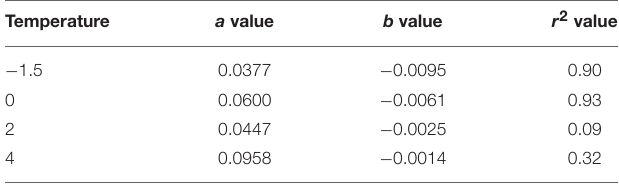
TABLE 5 | Model variables for maximal quantum yield based on irradiance at discrete temperatures. Temperature a value b value r 2 value − 1.5 0.0377 − 0.0095 0.90 0 0.0600 − 0.0061 0.93 2 0.0447 − 0.0025 0.09 4 0.0958 − 0.0014